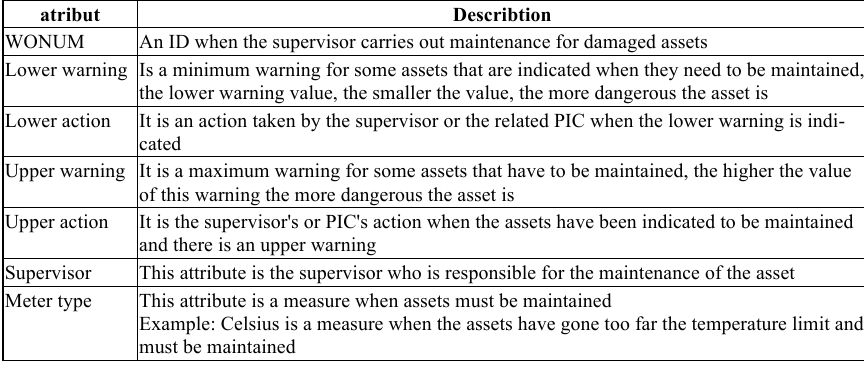
Table 4. Data Maintenance